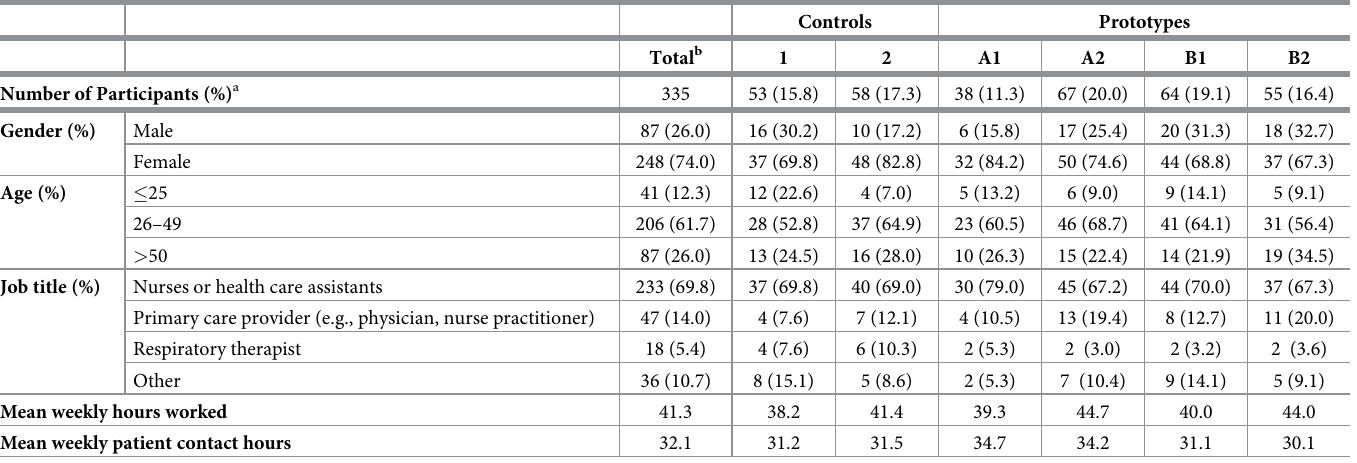
Table 1. Demographic characteristics of study participants and arm assignments.